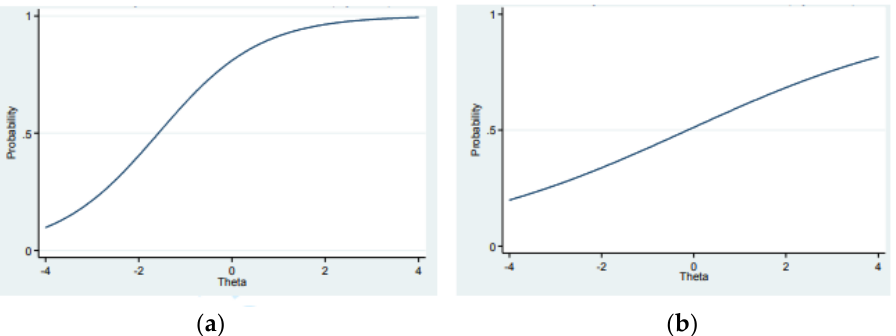
Figure 2. ( a , b ) show two different types of ICC curve. The x-axis (Theta) refers to the latent trait (ability) of the students, and the y-axis to the probability of getting a right answer.